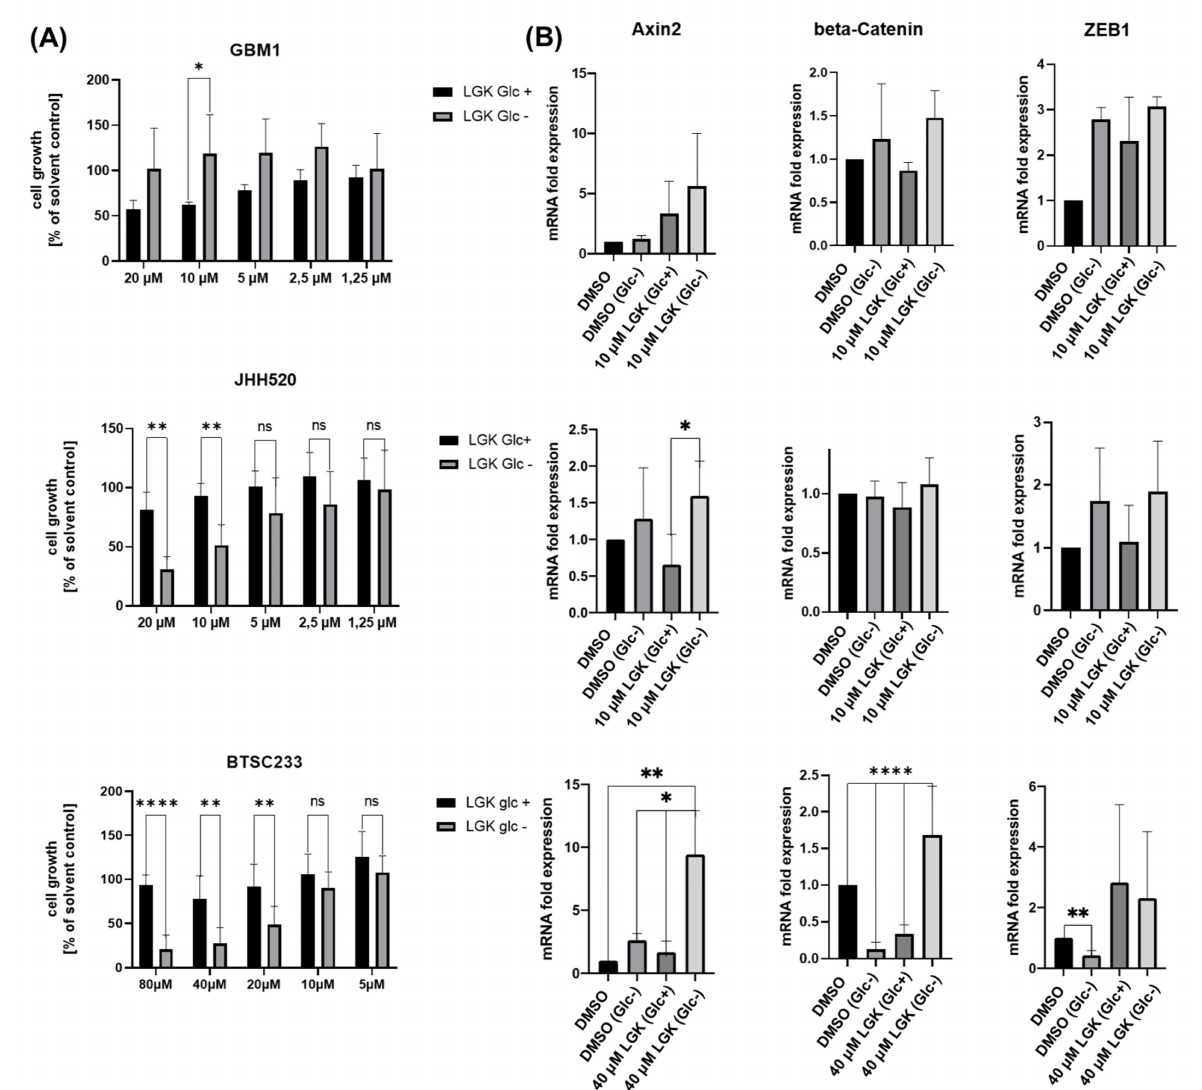
Figure 3. LGK974 sensitizes GSCs to glucose starvation-induced cell death and affects the mRNA expression of CTNNB1 and associated genes AXIN-2 and ZEB1 . ( A ) We assessed the viability of our GSC lines cultured in standard glucose concentrations of 450 mg/dL (Glc+) or in a glucose-depleted standard cell culture medium of 0 mg/dL (Glc − ) and simultaneously performed the pharmacological inhibition of WNT signaling with LGK974 (LGK) for a time period of 48 h. DMSO solvent controls were used for normalization. In order to normalize to the solvent control, equivalent amounts of DMSO were used in all conditions per cell line. LGK974 significantly decreased the viability